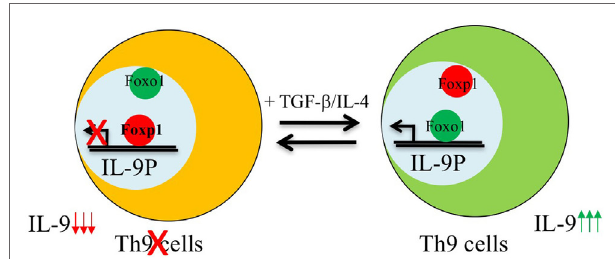
FiGURe 1 | Reciprocal regulation of Foxo1 and Foxp1 in the development of Th9 cells. Foxp1 is enriched and bound to interleukin (IL)-9 promoter in naive CD4 + T cells. Activation of naive T cells in the presence of Th9 polarizing cytokines induces Foxo1-co-activator p300 which recruits Foxo1 from cytoplasm to nucleus leading to displacement of Foxp1 from Foxo1 binding sites as both these factors bind to the same region in IL-9 locus, and therefore induces the development of Th9